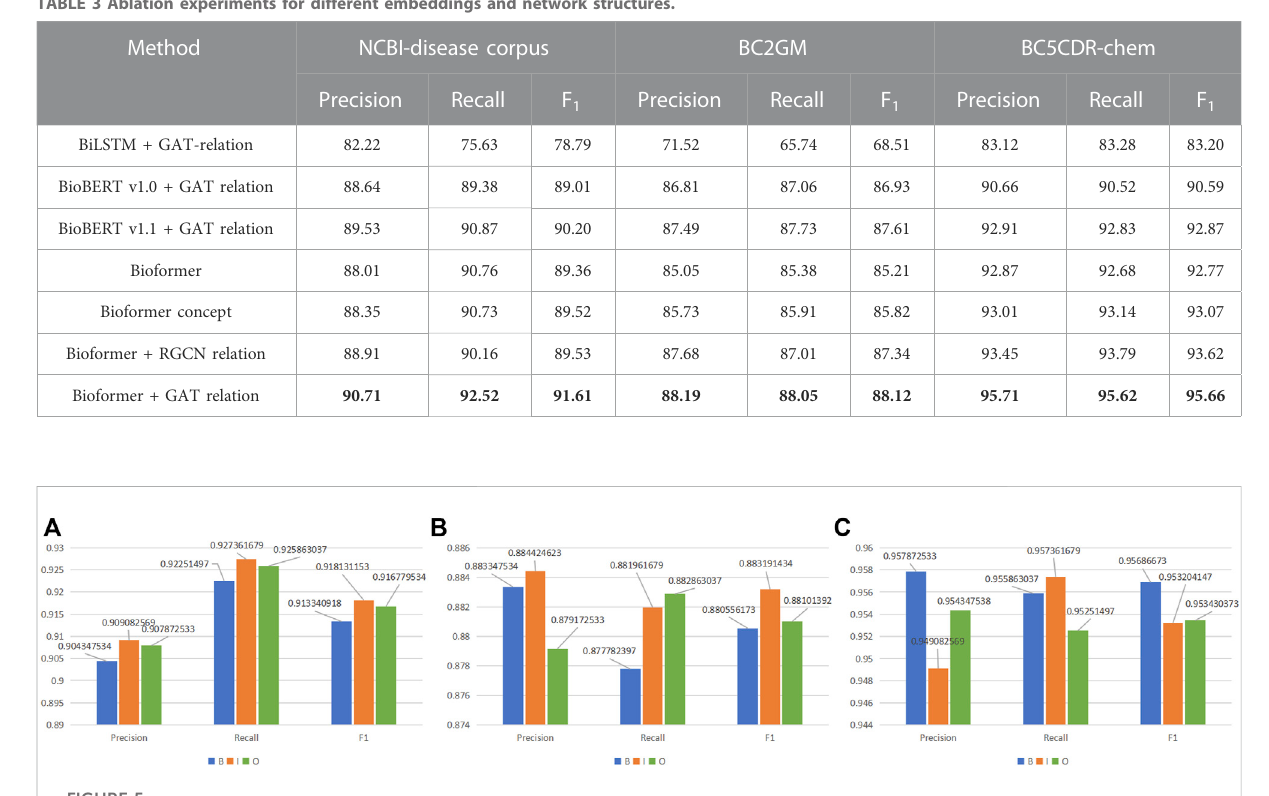
TABLE 3 Ablation experiments for different embeddings and network